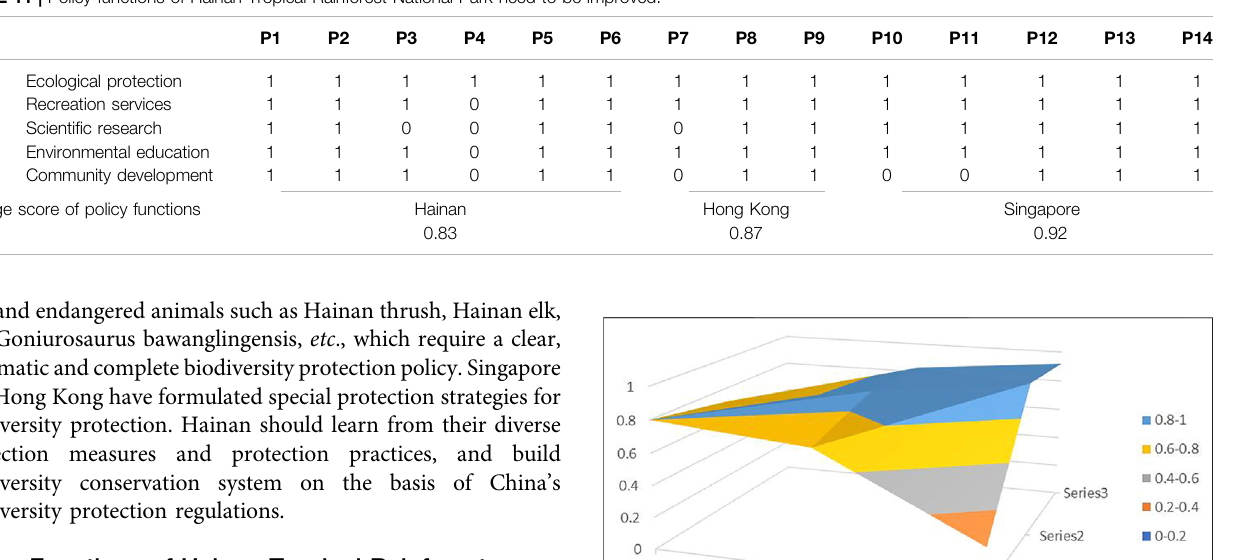
TABLE 11 | Policy functions of Hainan Tropical Rainforest National Park need to be